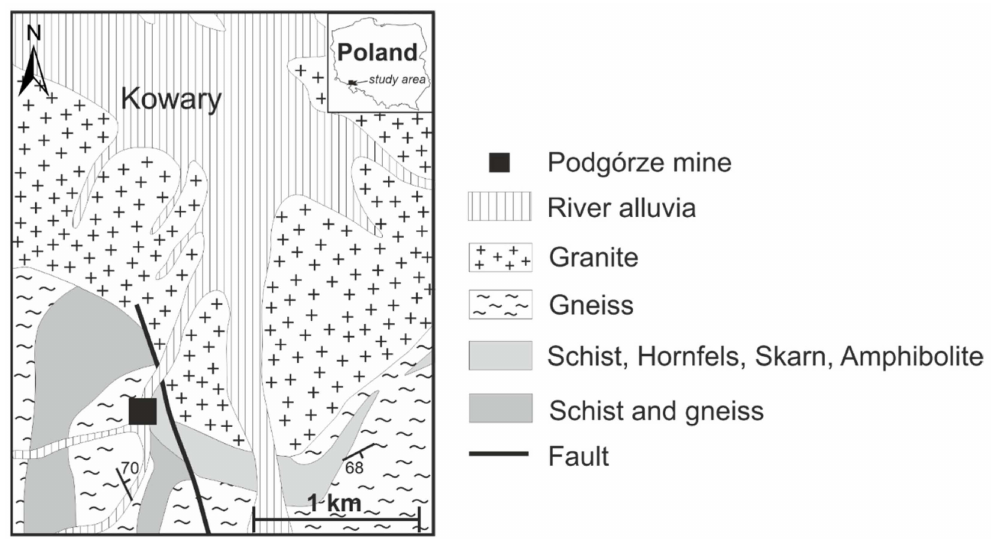
Figure 1. Geological sketch map of Podg ó rze mine area (based on https://mapy.geoportal.gov.pl/ imap/Imgp_2.html (accessed on 25 February 2022); [14]).